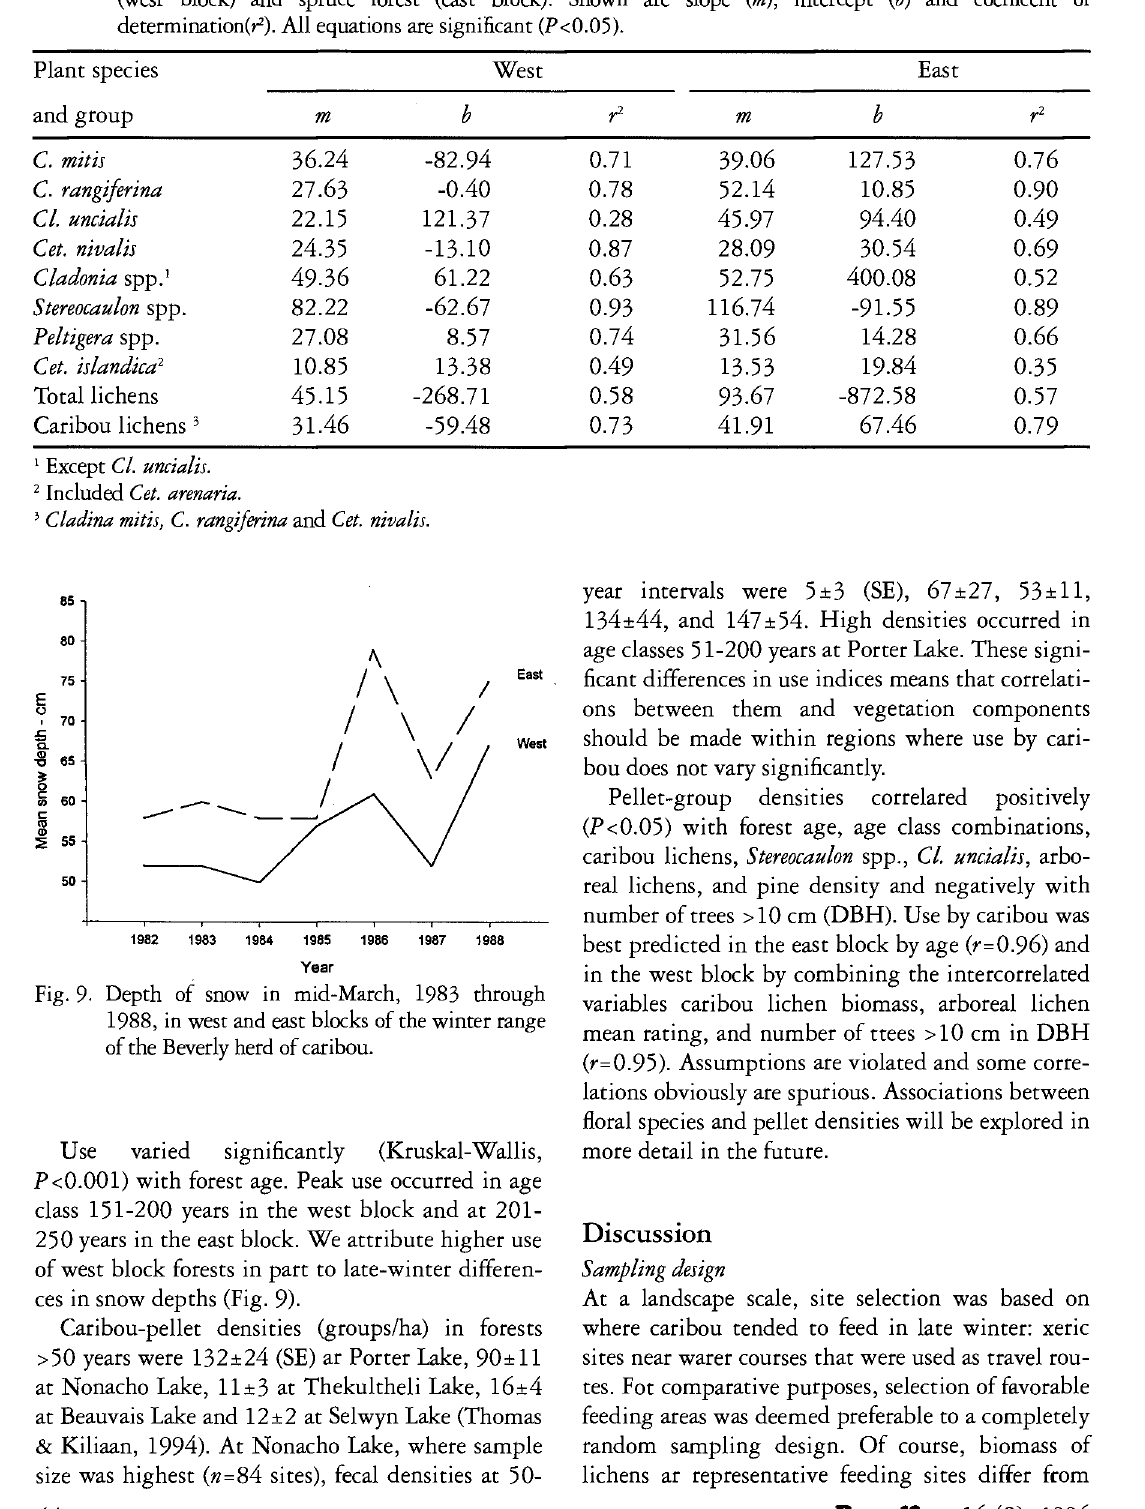
Table 5. Regression variables used ro predict biomass from cover of lichen species and groups in pine-spruce foresr (wesr block) and spruce forest (east block). Shown are slope (m), intercept (b) and coefficent of determination^). All equations are significant (P<0.05).